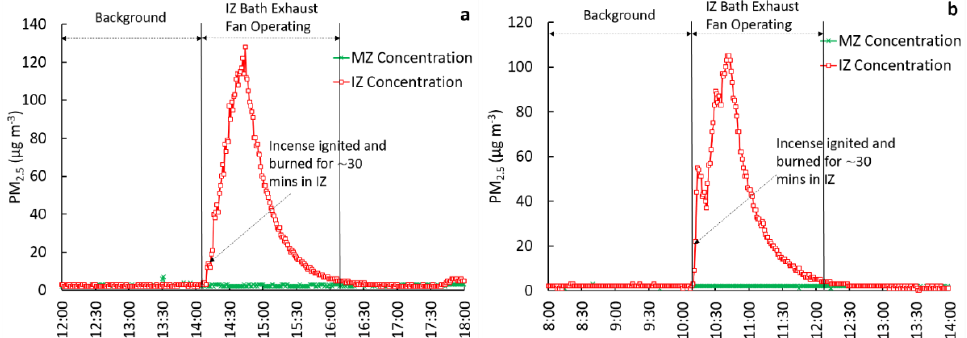
Figure 3. Comparison of PM 2.5 concentrations in the IZ and MZ under one IZ window open, exhaust ventilation off scenario (Test 3) with trial 1 on the left ( a ) and trial 2 on the right ( b ). a : explanation; b : explanation.